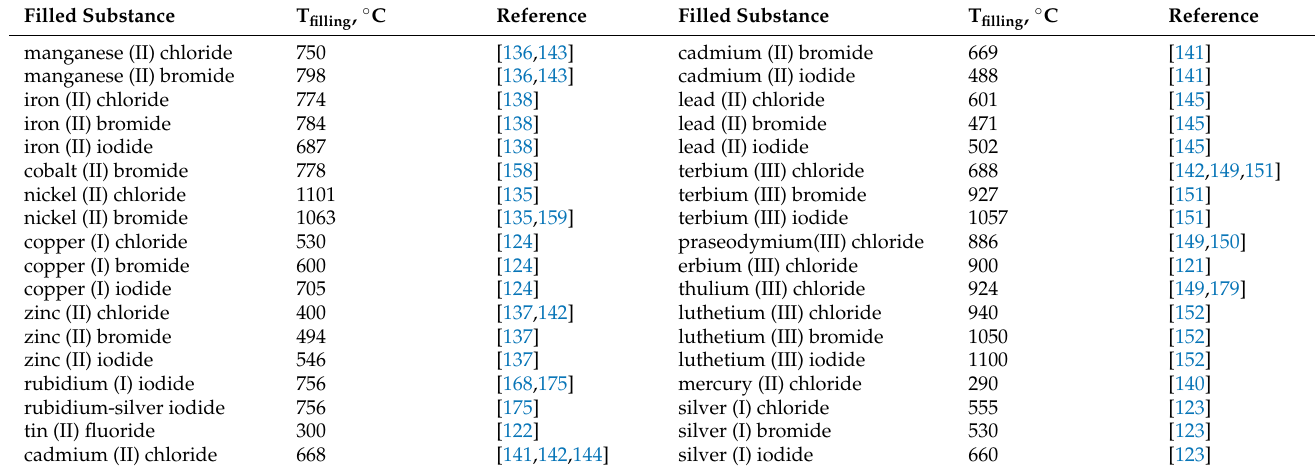
Table 1. Synthesis temperatures of nanocomposites X@SWCNT using the melt filling